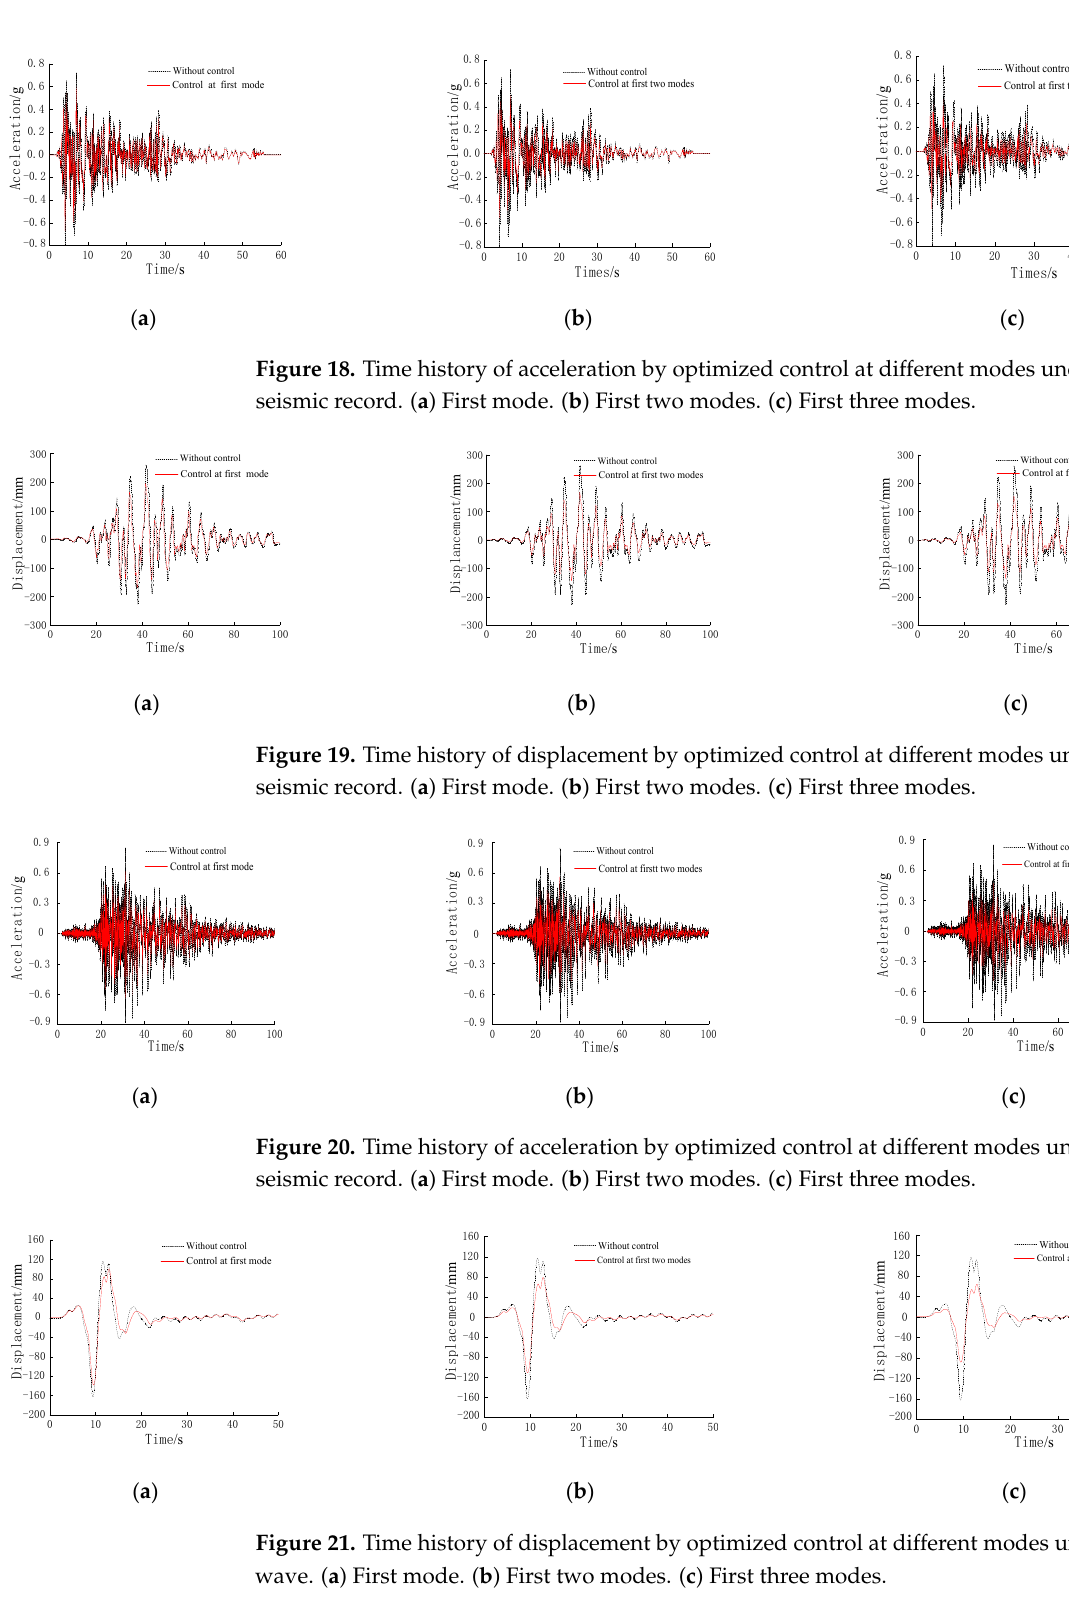
Figure 22. Time history of displacement by optimized control at different modes under the artificial wave. ( a ) First mode. ( b ) First two modes. ( c ) First three modes. Tables 9 and 10 show the maximum displacement and acceleration of the top level of the Small Wild Goose Pagoda obtained by optimally controlling the first mode, the first two modes, and the first three modes of the structure, with and without the SMA-SPDSs, under the 8-degree large earthquake (see Tables 9 and 10). A control effect coefficient (cid:2009) was introduced to reflect the control effect of the SMA-SPDSs on the seismic response of the Small Wild Goose Pagoda structure. (cid:2009) = |(cid:3025)|(cid:3015)(cid:2879)|(cid:3025)|(cid:3026) |(cid:3025)|(cid:3015) where |(cid:1850)|(cid:1840) is the seismic response of the Small Wild Goose Pagoda structure without the SMA-SPDSs, and |(cid:1850)|(cid:1851) is the seismic response of the Pagoda structure with the opti- mized SMA-SPDSs. The analysis of Figures 17–22 shows that by controlling different order modes, the displacement and acceleration of the original structure of the Small Goose Pagoda were controlled. The control of the top floor increased significantly with the number of modes that we controlled on the Small Wild Goose Pagoda. Table 10 shows that when the first two modes of the original structure of the Pagoda were controlled, the displacement re- sponse of the structure was 32.4% lower, and the acceleration was 31.1% lower on average under the action of the 8-degree shock. When controlling the first three modes, the dis- placement and acceleration responses of the Pagoda decreased by averages of 43.8% and 43.3%, respectively. We emphasize that more SMA-SPDSs are required to control more modes. The control effect on the Small Wild Goose Pagoda was significantly improved by using more SMA-SPDSs.